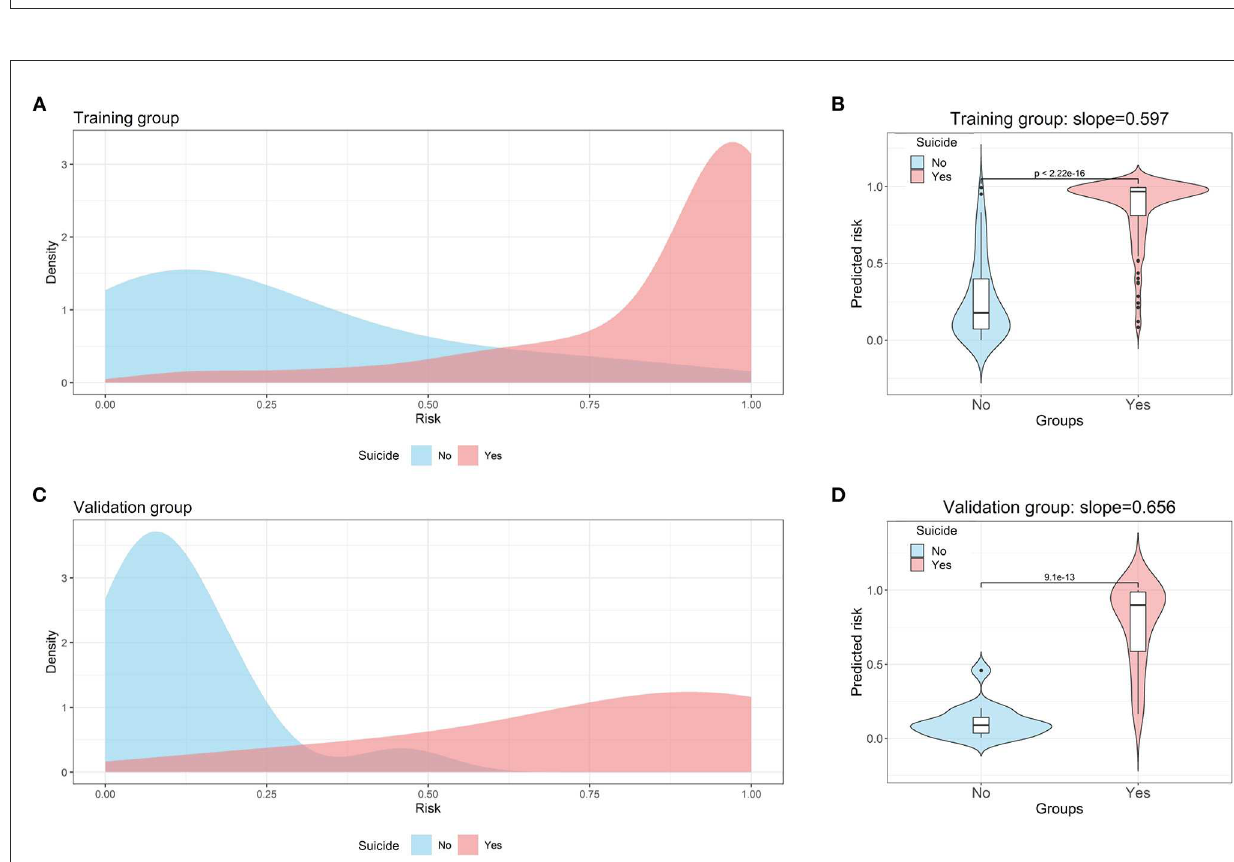
FIGURE3 Area under the curve (AUC) for the nomogram. (A) The training group. (B) The validation group. The light blue indicates the AUC, and its value and the optimal cut-off were provided.